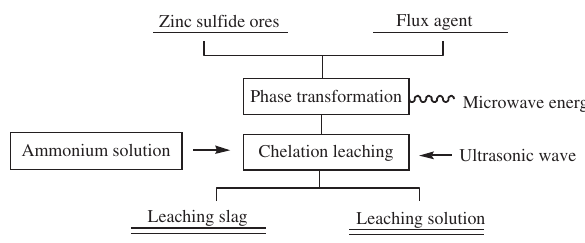
Figure 2: Leaching diagram of zinc sulfide ores.